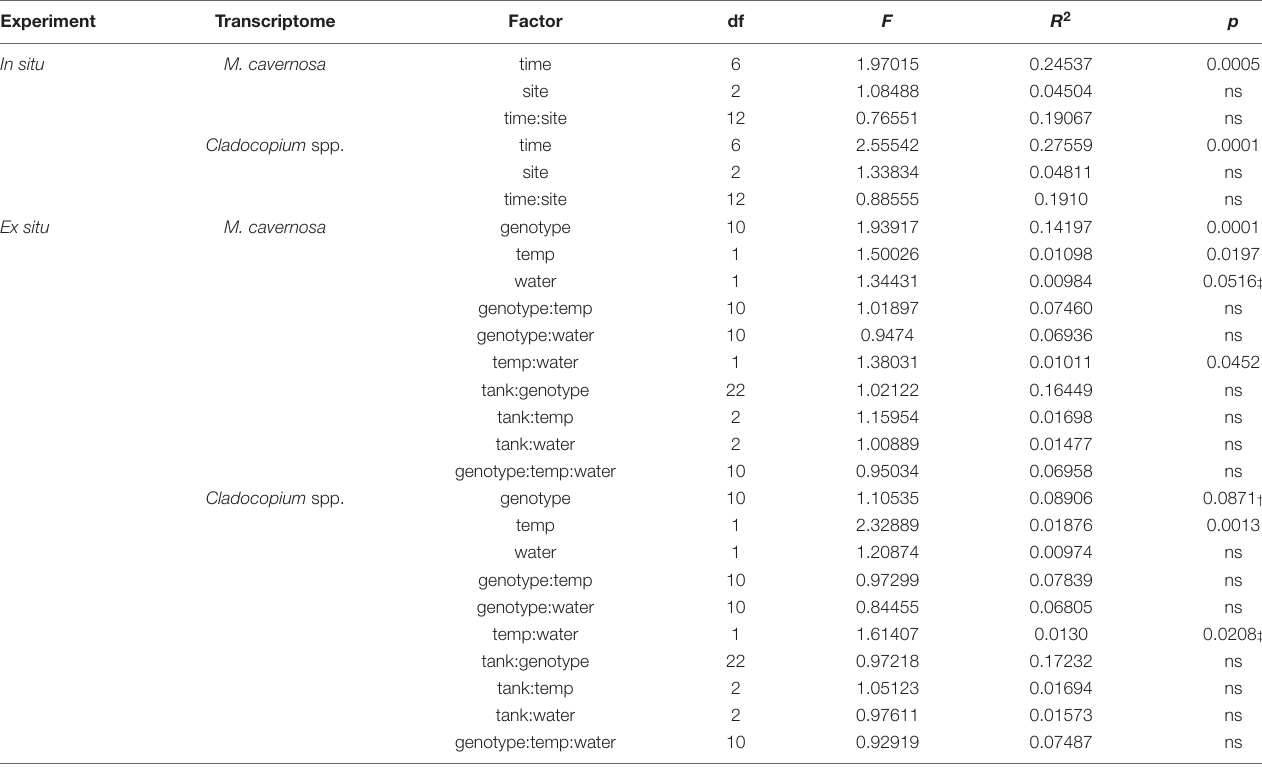
TABLE 3 | PERMANOVA model results for in situ and ex situ experiments, split into coral host ( M. cavernosa ) and symbiont ( Cladocopium spp.) datasets. Experiment